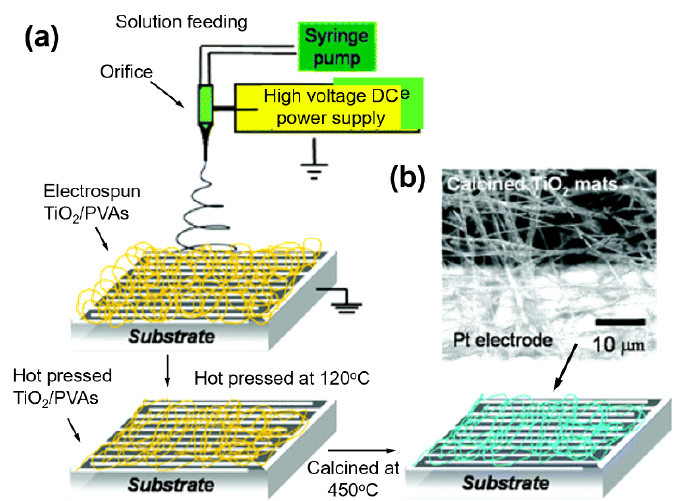
Figure 10. ( a ) Schematic diagram of the processing steps used to fabricate TiO 2 nanofiber mats on Al 2 O 3 substrates with interdigitated Pt electrode arrays. PVA (Polyvinyl acetate); and ( b ) the micrograph of a calcined TiO2 nanofiber mat on top of the Al 2 O 3 substrate (dark region) and Pt electrode (bright region). Reprinted from reference [201] with permission from the American Chemical Society.